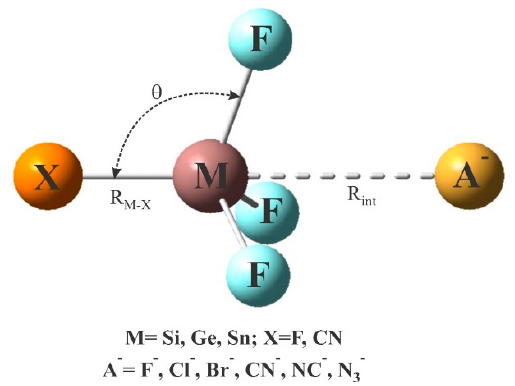
Scheme 1. Representative geometrical structure of anionic tetrel-bonded complexes.